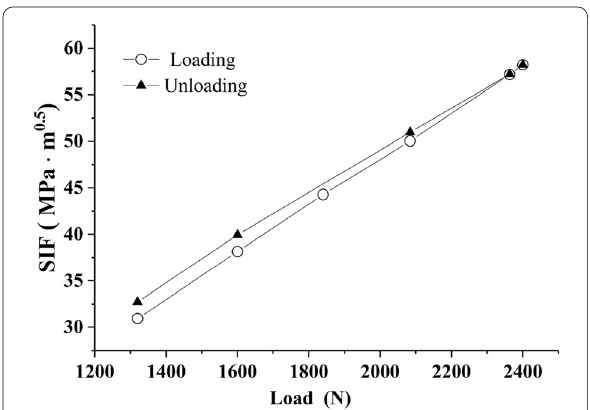
Figure 7 SIF during loading and unloading of various loads